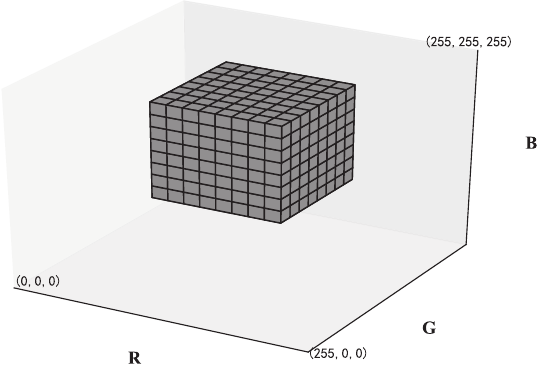
Figure 6. The wood color subspace in the RGB (red, green, blue) color space with N b =